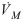
Comparison of viral infection effects on baseline V˙M among Ctrl, HK483, and HK486 mice.V˙M was daily measured in the individual mouse at 2 and 1 days before and 1, 2, and 3 days after intranasal inoculation (Day -2, -1, 1, 2, and 3). V˙M, minute ventilation; fR, respiratory frequency; and VT, tidal volume. Mean ± SE. n = 6, 15, and 7 for Ctrl, HK483 and HK486 mice. * P < 0.05 compared to the data obtained in previous day(s) and † P < 0.05 compared to Ctrl and HK486 mice at the same time-point. Tachypnea (elevation of minute ventilation) is induced in HK483 but not HK486 mice at 2 and 3 dpi.